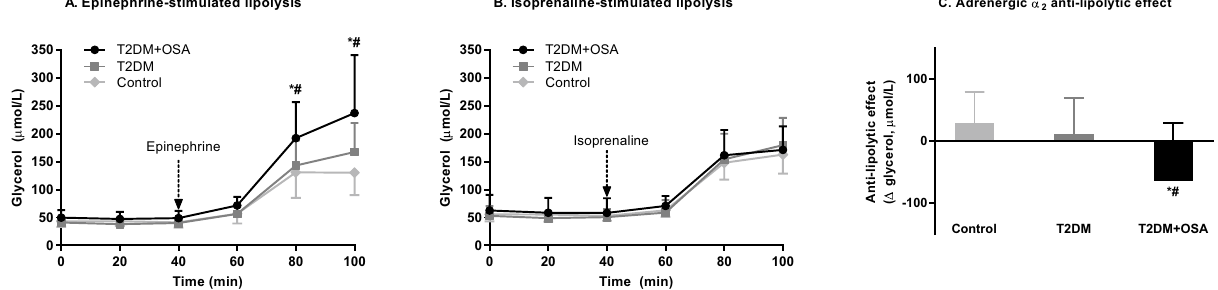
Figure 1. Lipolytic rate in subcutaneous abdominal adipose tissue. ( A ) Lipolytic rate after 10 μmol/L epinephrine administration in subcutaneous abdominal adipose tissue in all experimental groups. ( B ) Lipolytic rate after 10 μmol/L isoprenaline administration in subcutaneous abdominal adipose tissue in all experimental groups. ( C ) Presentation of the α 2 -anti-lipolytic effect in subcutaneous abdominal adipose tissue in all experimental groups. T2DM + OSA (n = 11), T2DM (n = 10), control group (n = 14). * p < 0.05 for differences between T2DM + OSA and a control group (repeated measures ANOVA with post-hoc tests). # p < 0.05 for differences between T2DM + OSA and T2DM group (repeated measures ANOVA with post-hoc